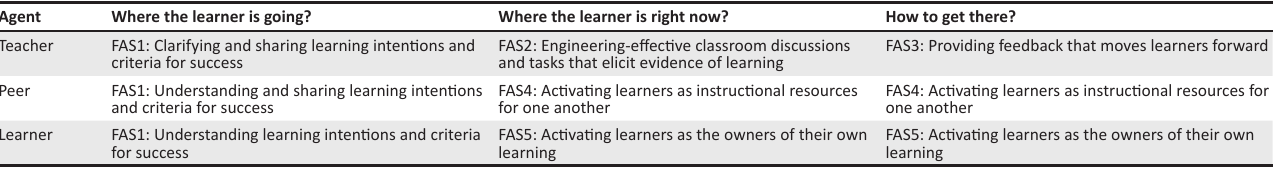
TABLE 1: Formative assessment strategies, key processes and key agents in the classroom.